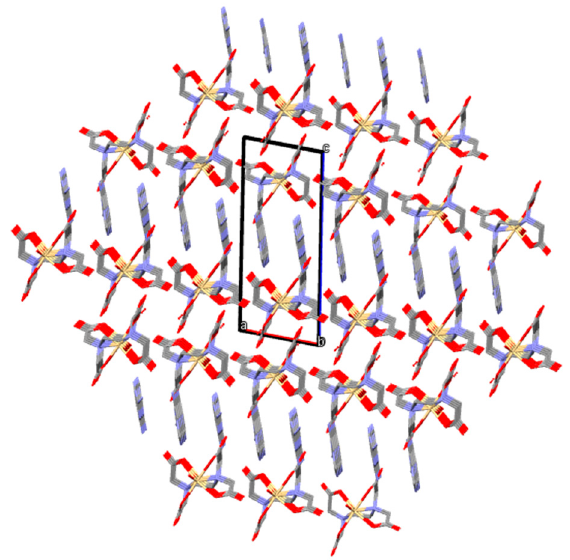
Figure 5. In the 3D H-bonded crystal of compound 1 , 2,6-diaminopurinium(1+) cations oriented towards the external faces of 2D H-bonded frameworks build by complex anions and unbounded to the cadmium(II) water molecules. All H atoms and H-bonding interactions are omitted for clarity.